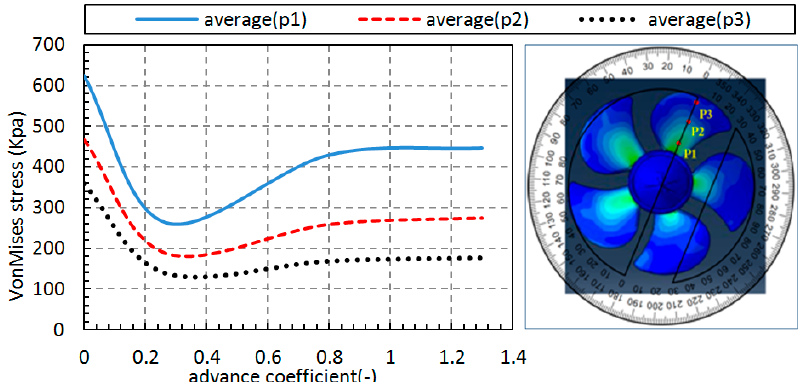
Figure 12. Maximum von Mises stress on a blade versus advance coefficient.